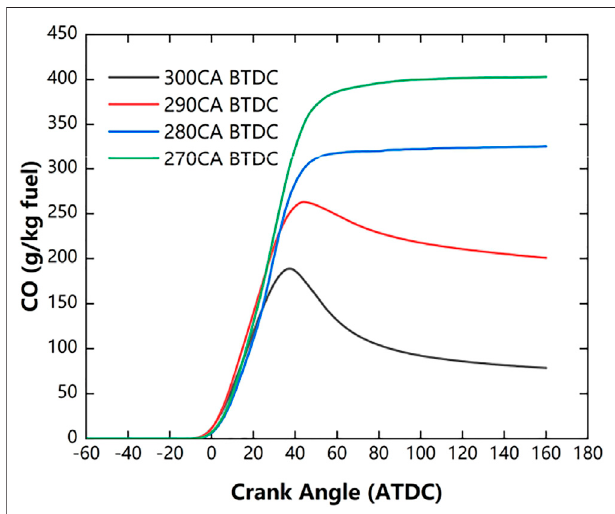
FIGURE 16 | Effect of injection timing on soot formation.